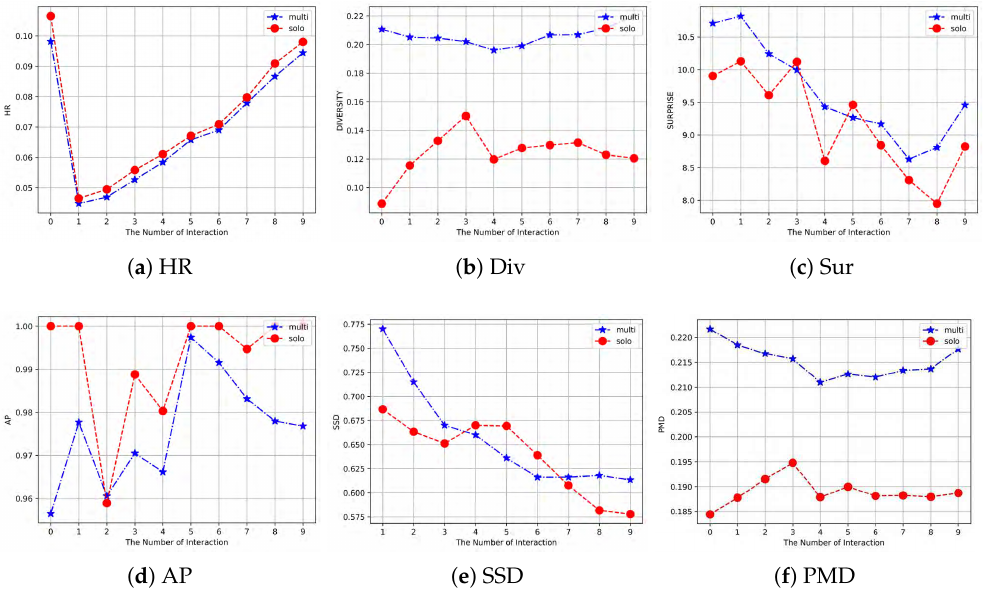
Figure 6. The recommendation performance of the two algorithms on six metrics when performing interactions in the Music